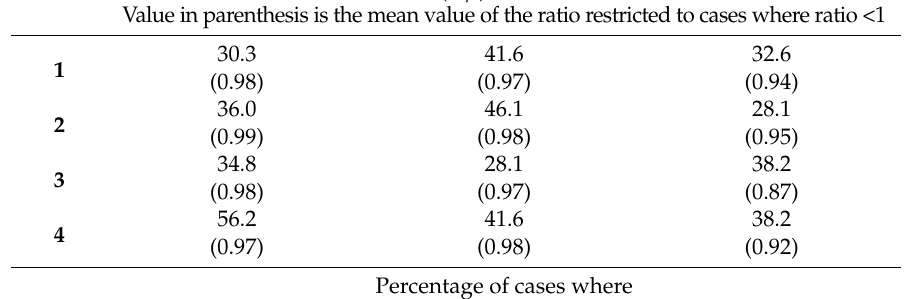
µ cp < 1 and µ cp v cp